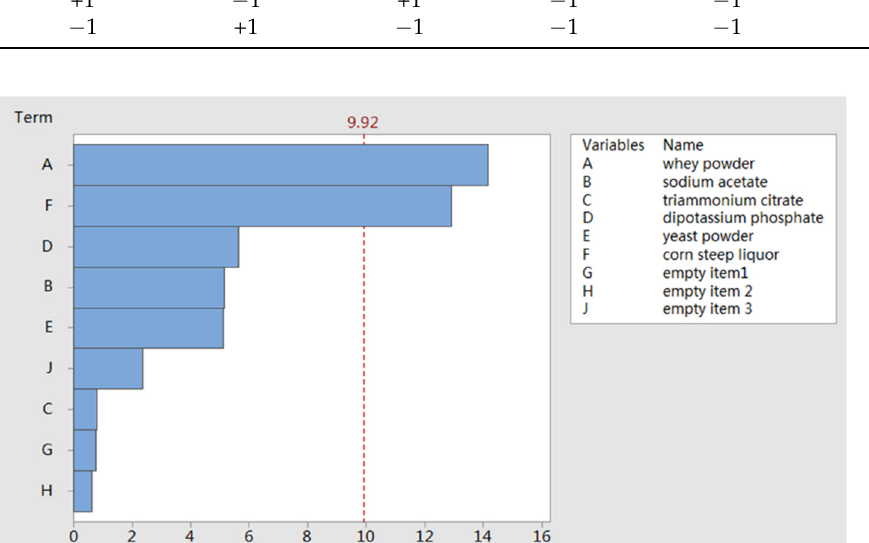
Figure 2. Pareto chart of standardized effects. Response is enzyme activity (U/L). α = 0.01.